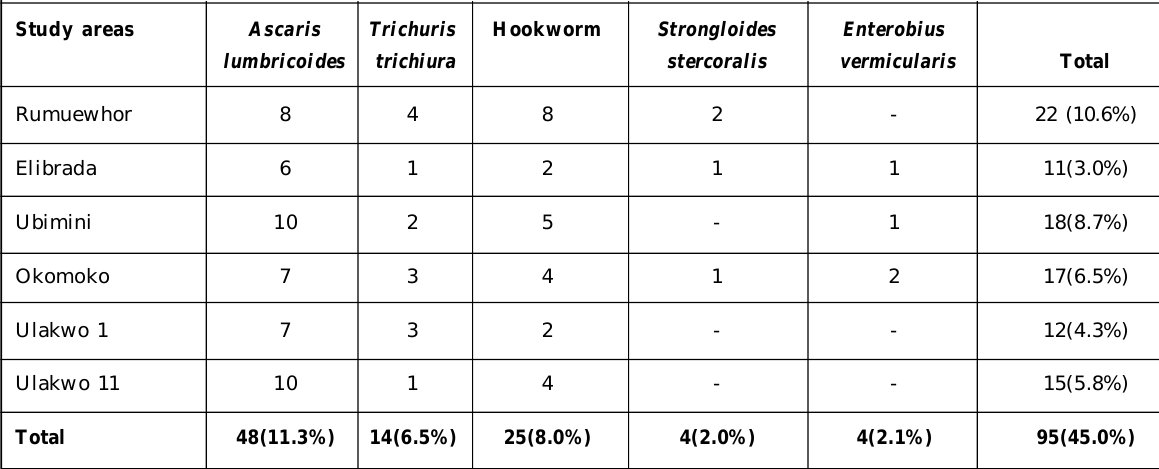
Table 1: Isolated parasites from the soil samples in the soil areas Study areas Ascaris Trichuris Hookworm